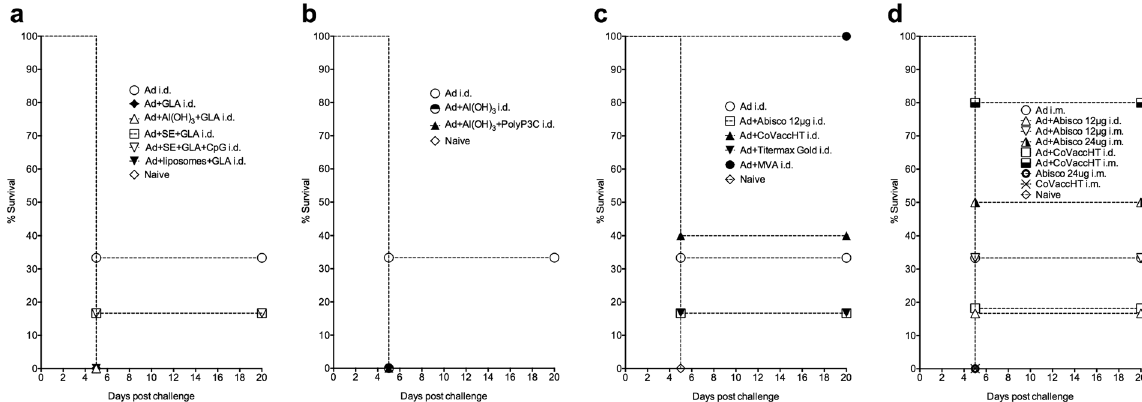
Figure 1. Survival graphs for mice challenged with malaria following immunisation with different Ad-ME. TRAP/adjuvant combinations. Balb/c mice (n = 6 to 10) were vaccinated with a single dose of Ad-ME.TRAP pre-erythrocytic malaria vaccine (5 × 10 9 v.p./dose) alone or in combination with different adjuvants ( a to d ). Two weeks post-immunisation the animals were challenged i.v. with 1,000 P . berghei sporozoites and the vaccine efficacy measured by assessing parasitaemia in the blood following the challenge. Absence of parasitaemia at 3 weeks post-challenge indicated sterile protection from malaria. The baseline level of protection with the unadjuvanted Ad-ME.TRAP vaccine was around 30% (2/6 mice) in repeated experiments. Only two adjuvants, Abisco ® -100 and CoVaccineHT TM were able to enhance the vaccine efficacy. Each symbol is a median